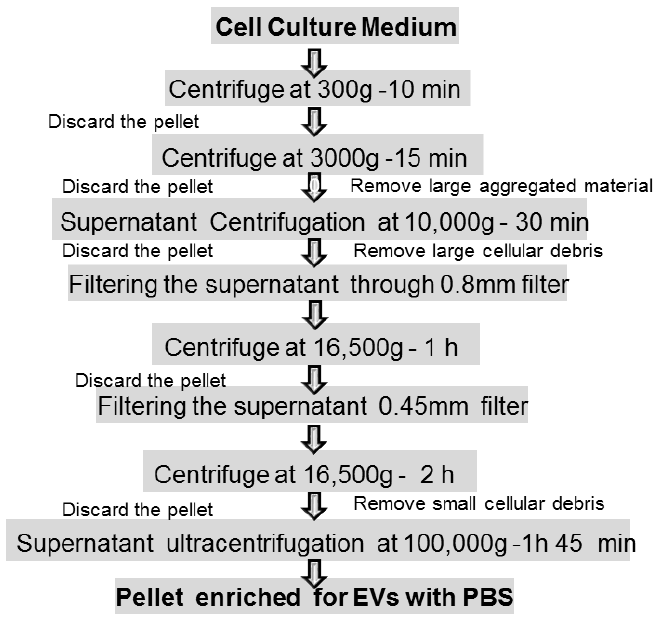
Figure 4. Steps of differential ultracentrifugation for exosome isolation from cell culture medium.